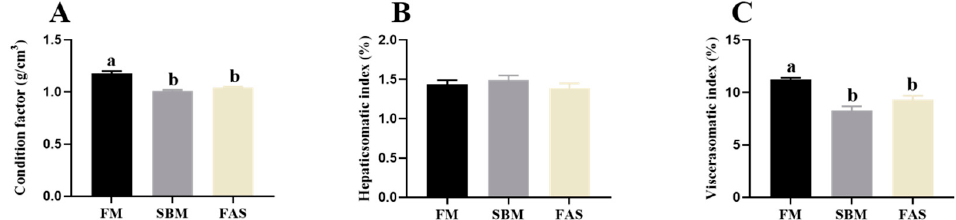
Figure 2. Body indexes of Japanese seabass fed diets using soybean meal as fishmeal alternative with or without functional additives. ( A ) Condition factor. ( B ) Hepaticsomatic index. ( C ) Viscerasomatic index. Data are presented as means ± SEM. Bars sharing the same letters are not significantly different ( p > 0.05, n = 12).